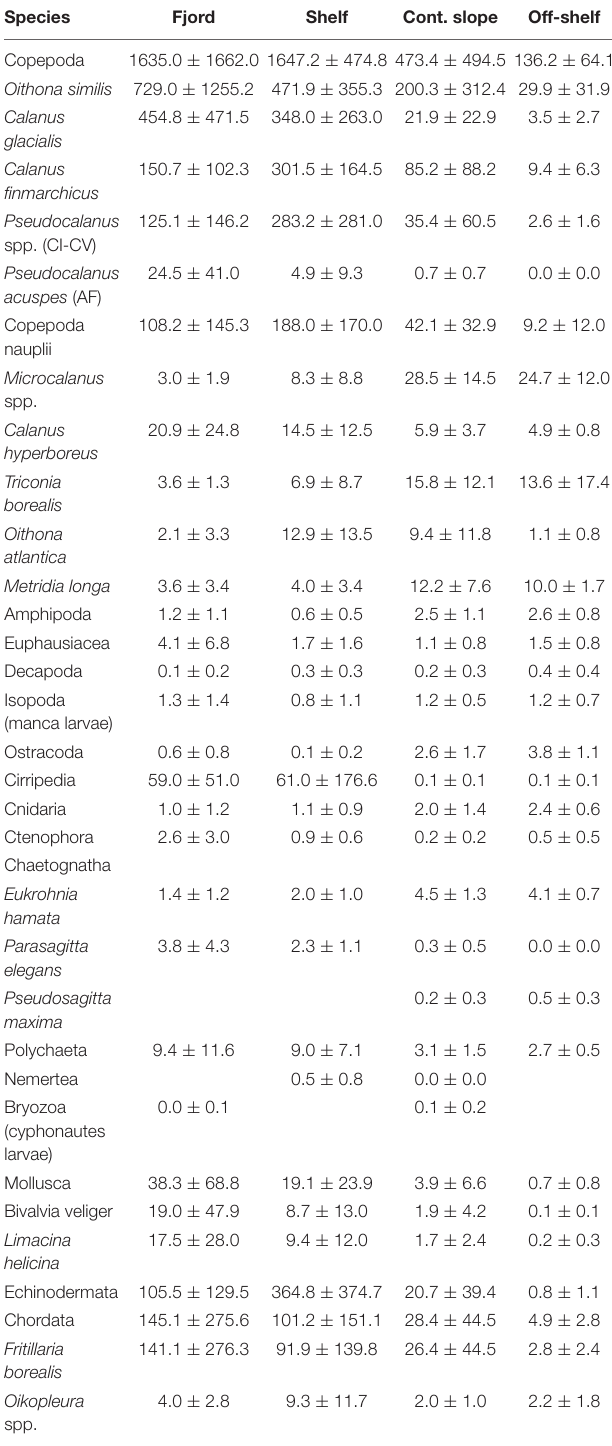
TABLE 2 | Mean zooplankton abundance (ind. m − 3 ) and standard deviation of major taxonomical groups and 16 most abundant taxa across the four areas of the